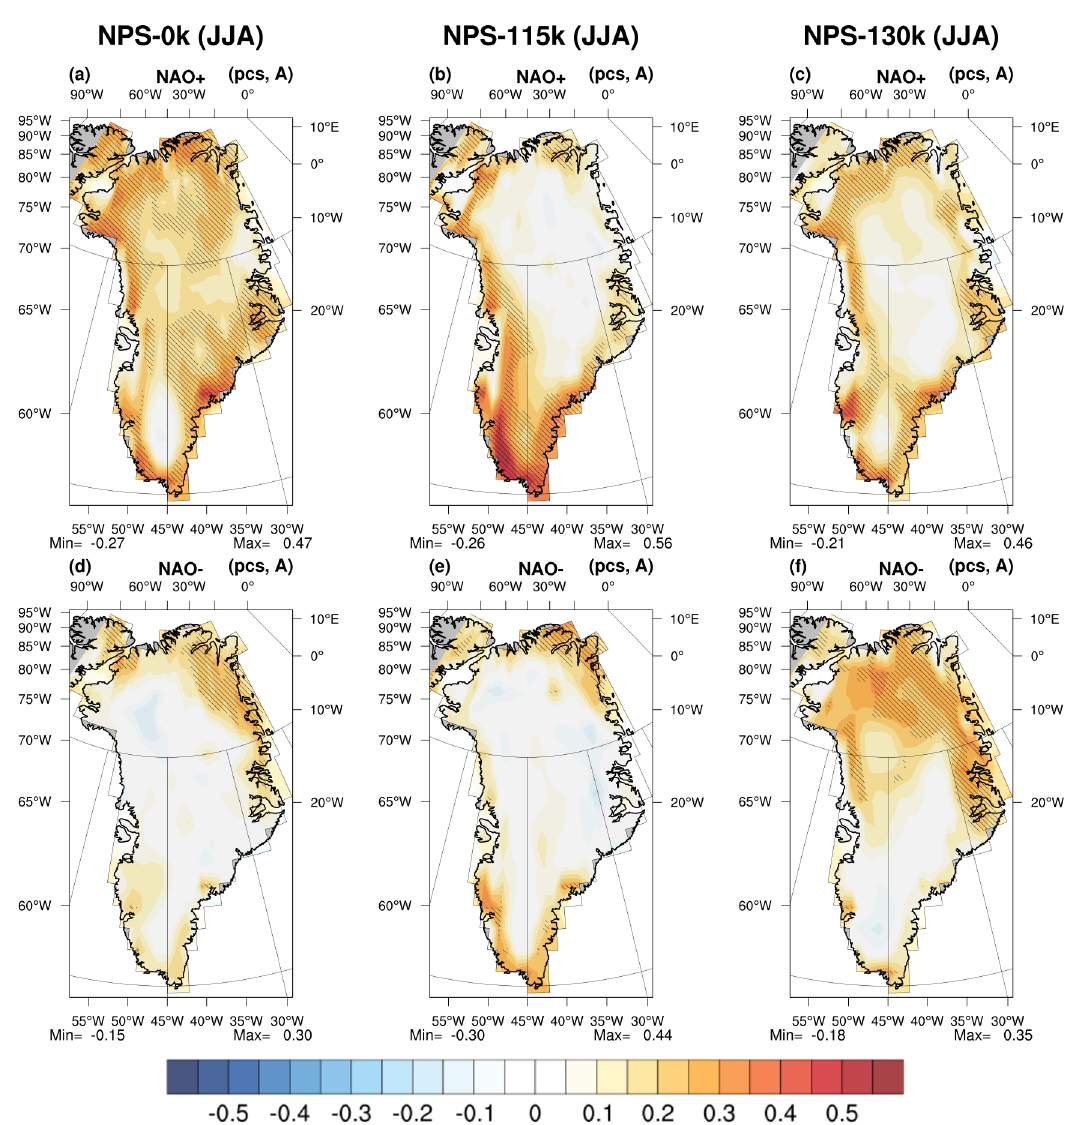
Figure 13. Same as Fig. 12, but for spatial correlation between melting and the NAO index.